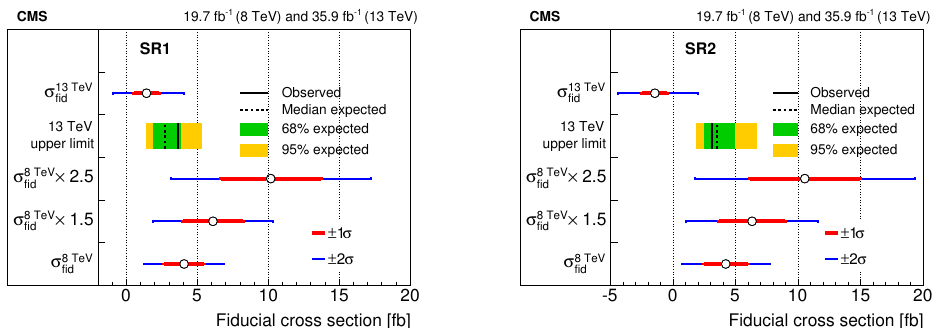
Figure 3 . The measured (cid:12)ducial signal cross sections and the 95% CL upper limits on those in SR1 (left) and SR2 (right). The expected (observed) upper limits are shown as vertical dashed (solid) lines, together with the 68 and 95% CL uncertainties in the expected limits (under the background- only hypothesis). Also shown are the expected 13 TeV cross sections and their uncertainties obtained by scaling the measured 8 TeV cross sections by the factors of 1.5 and 2.5, as discussed in the